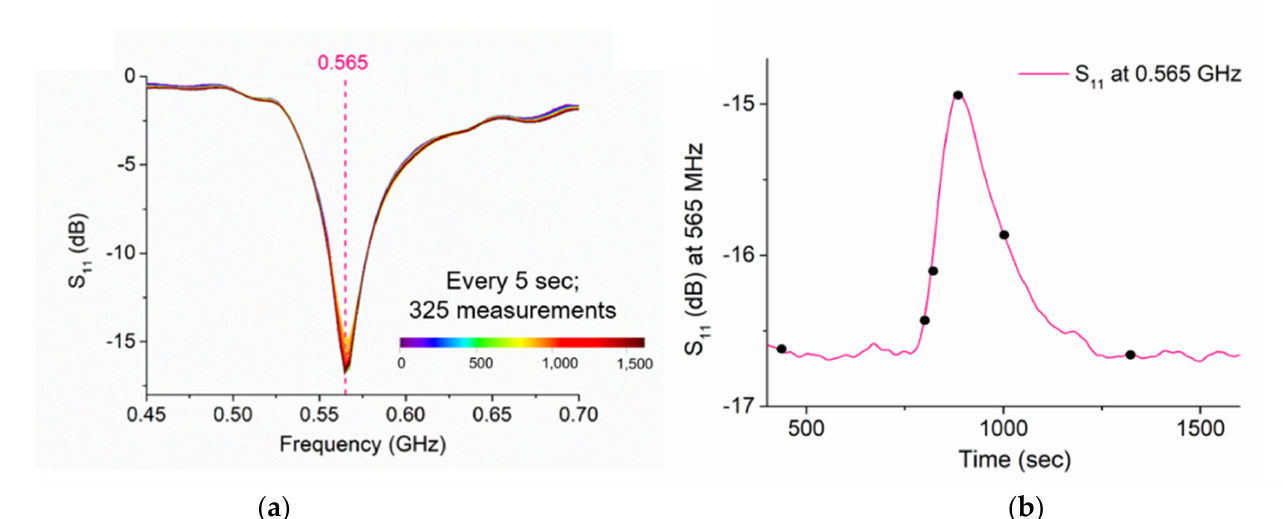
Figure 12. ( a ) Results from an experimental trial of a slug injection of NaCl using lacquered sensors probing the Nant Cwmnewyddion water measured every 5 s for 1625 s (27 min), demonstrating the feasibility of measuring, in situ and in real time, the variation in a water parameter ( a ); ( b ) the variation in the S 11 response at 0.565 GHz by time and its return to the baseline once the concentration decreases. Table 5. Variation in EC and S 11 signal by time due to change in salt in situ and in real time and the return to the baseline spectrum. NaCl was successively measured by applying conversion equations.